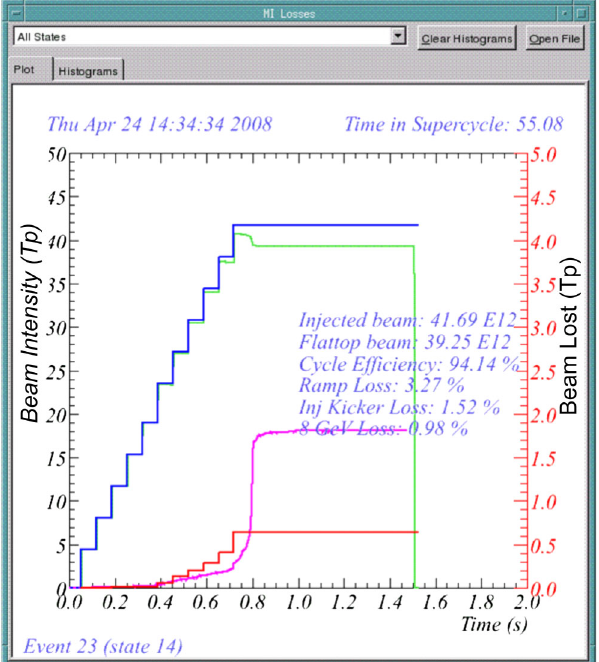
FIG. 8. Typical beam operation for pbar plus NuMI beam production shows the beam intensity vs time in the acceleration cycle. Acceleration begins at 0.755 sec. Intensities shown are blue (sum of injected beam), green (circulating beam in Main Injector), red (loss from injection process), and magenta (total loss in